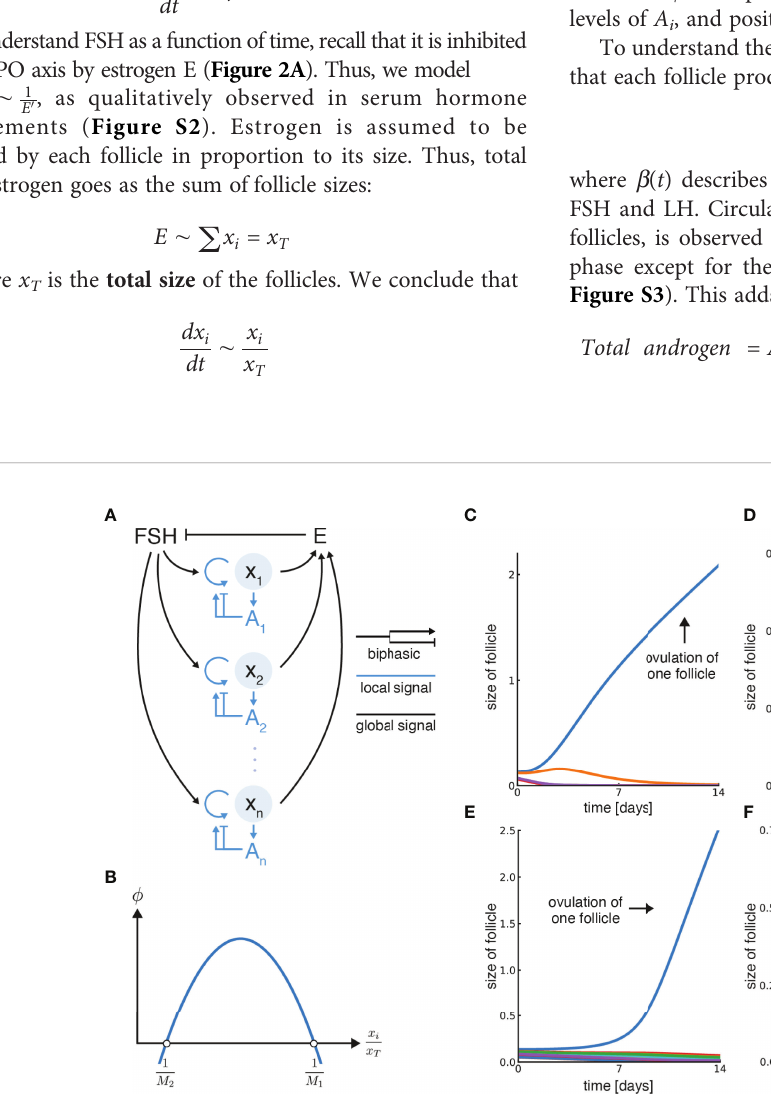
FIGURE 2 | Model for ovulation number control based on a biphasic effect of local androgen. (A) Growth of individual follicles x i in the model is controlled by systemic feedback (circulating FSH and Estradiol, E) and local feedback (androgen concentration at each follicle, Ai). Follicles secrete estradiol and contribute to the total circulating estradiol, E, which inhibits FSH. Both local (intra-follicular) androgen and FSH control follicular growth, where FSH promotes it and androgen has a , is described by the function f . Its zero- biphasic effect. (B) Biphasic control of follicular growth by androgen, which is proportional to the relative follicle size x i x T crossing points are 1 M and 1 M . (C) Simulation of the model with fi ve initial follicles and M 1 = 0.9, M 2 = 3.5, in which a single follicle ovulates. (D) Simulation with fi ve 1 2 initial follicles, M 1 = 2.9, M 2 = 7.5, in which three follicles ovulate. (E) Simulation with M 1 = 0.9, M 2 = 10 and 15 initial follicles in which one follicle ovulates. (F) Simulation with M 1 = 5.9, M 2 = 13 and 15 initial follicles in which six follicles ovulate. Note that units of time can be rescaled by multiplying f by a velocity constant ( a ), and were set so the simulation lasts 14 days by a suitable constant in each